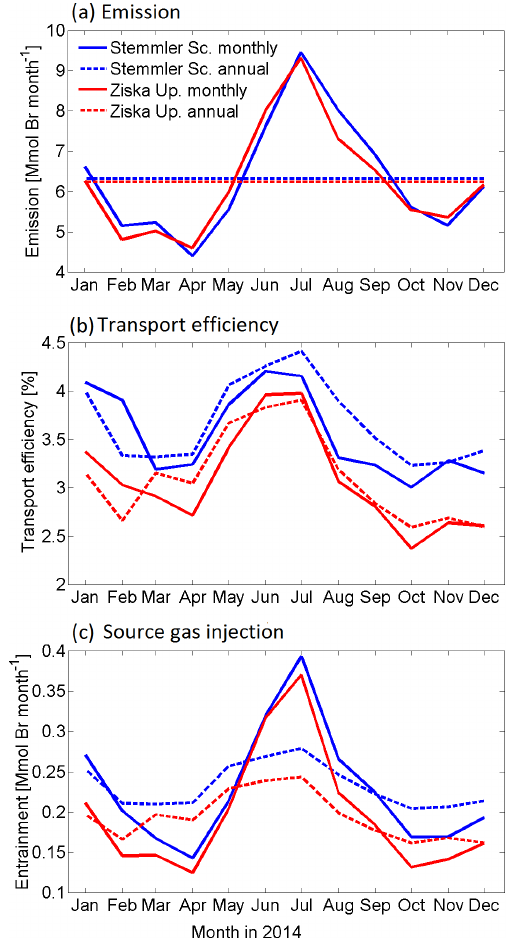
Figure 6. Annual cycles of monthly sums of bromoform (a) emis- sion, (b) transport efficiency, and (c) source gas injection above the CPT in 2014 for the Ziska Updated and Stemmler Scaled monthly and annually averaged bromoform emission scenarios for the time of particle